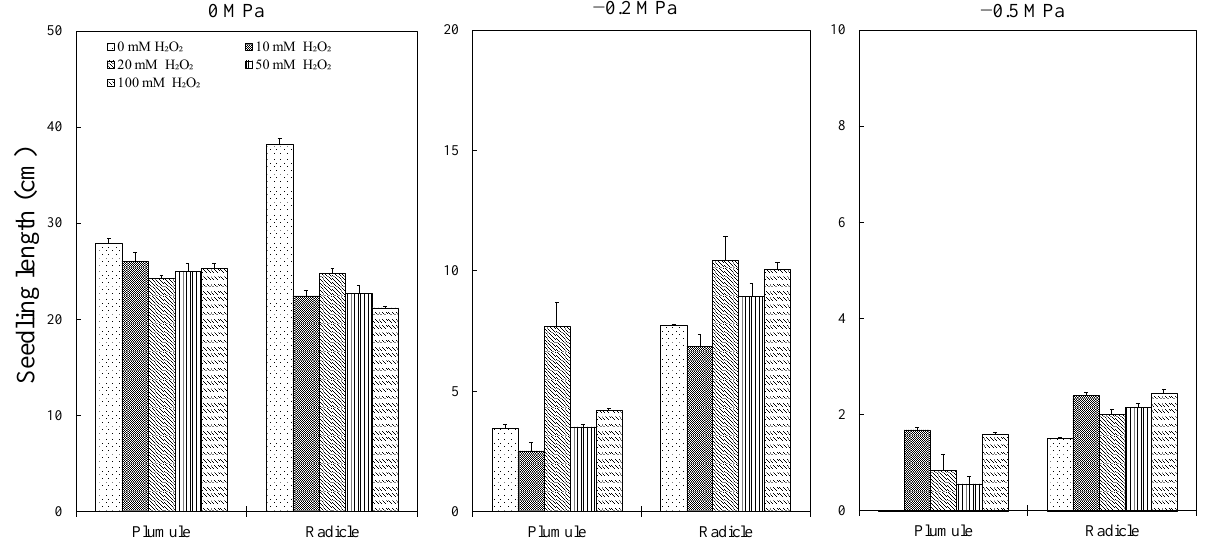
Figure 3. Effects of hydrogen peroxide on the growth of plumule and radicle from the embryonic axis of sorghum seed under various water potentials. Plumule and radicle lengths were measured after 120 h of imbibition. All values are the means ± SE of three replicates of 30 seeds each. Columns with the same letters are not significantly different between treatments according to Tukey’s test ( p < 0.05).